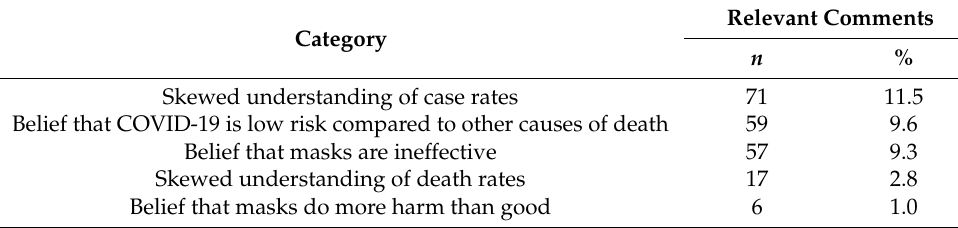
Table 2. Themes related to confusion/misinformation.